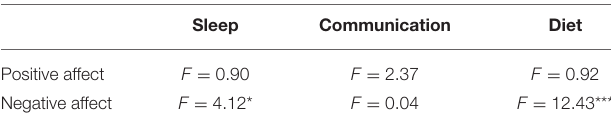
TABLE 1 | ANOVA for the differences of affect among changes of daily behaviors ( N = 457). Sleep Communication